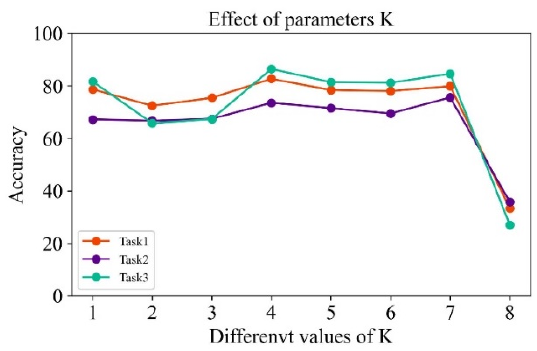
Figure 8. Effect of K value on